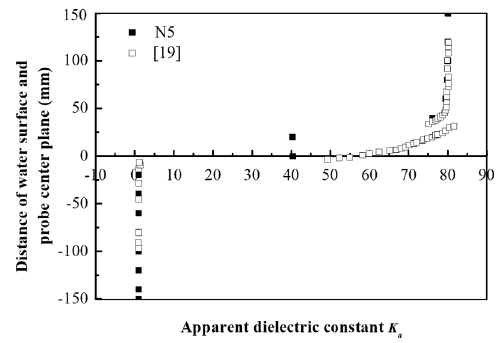
Figure 11. Calculated relative dielectric permittivity by model N5 and the measured values reported by [19] as a function of the distance of the air–water interface to the probe midpoint plane.